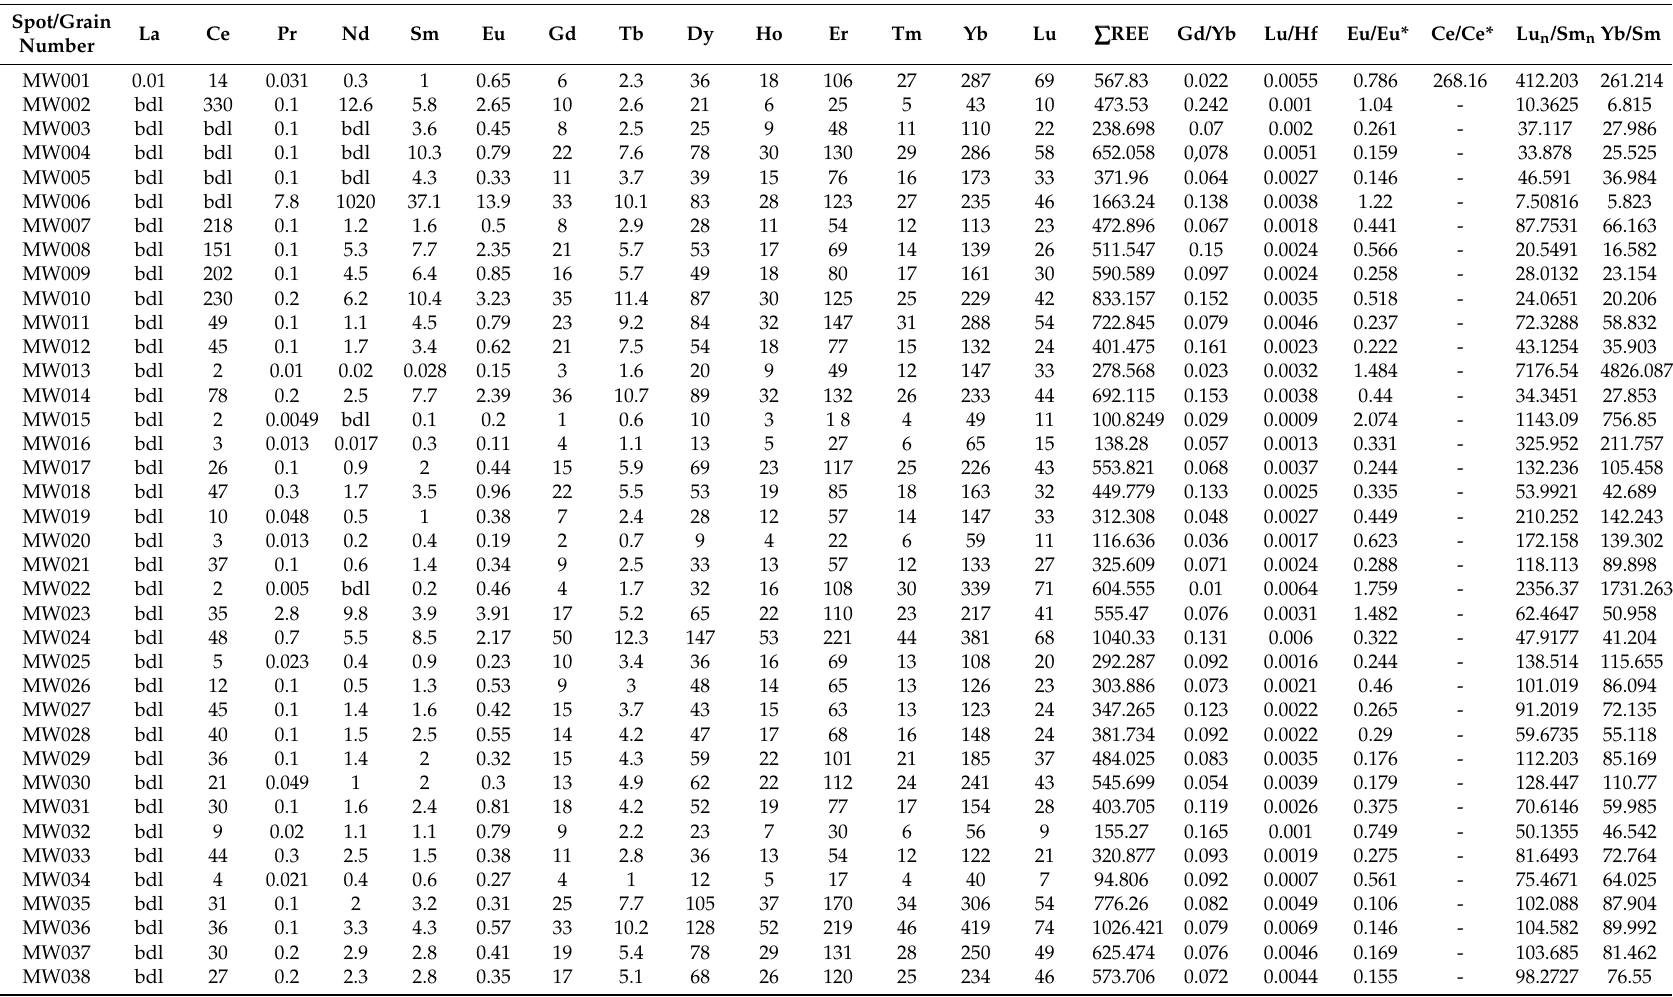
Table 2. Rare earth element abundance (in ppm) in the western Meiganga detrital